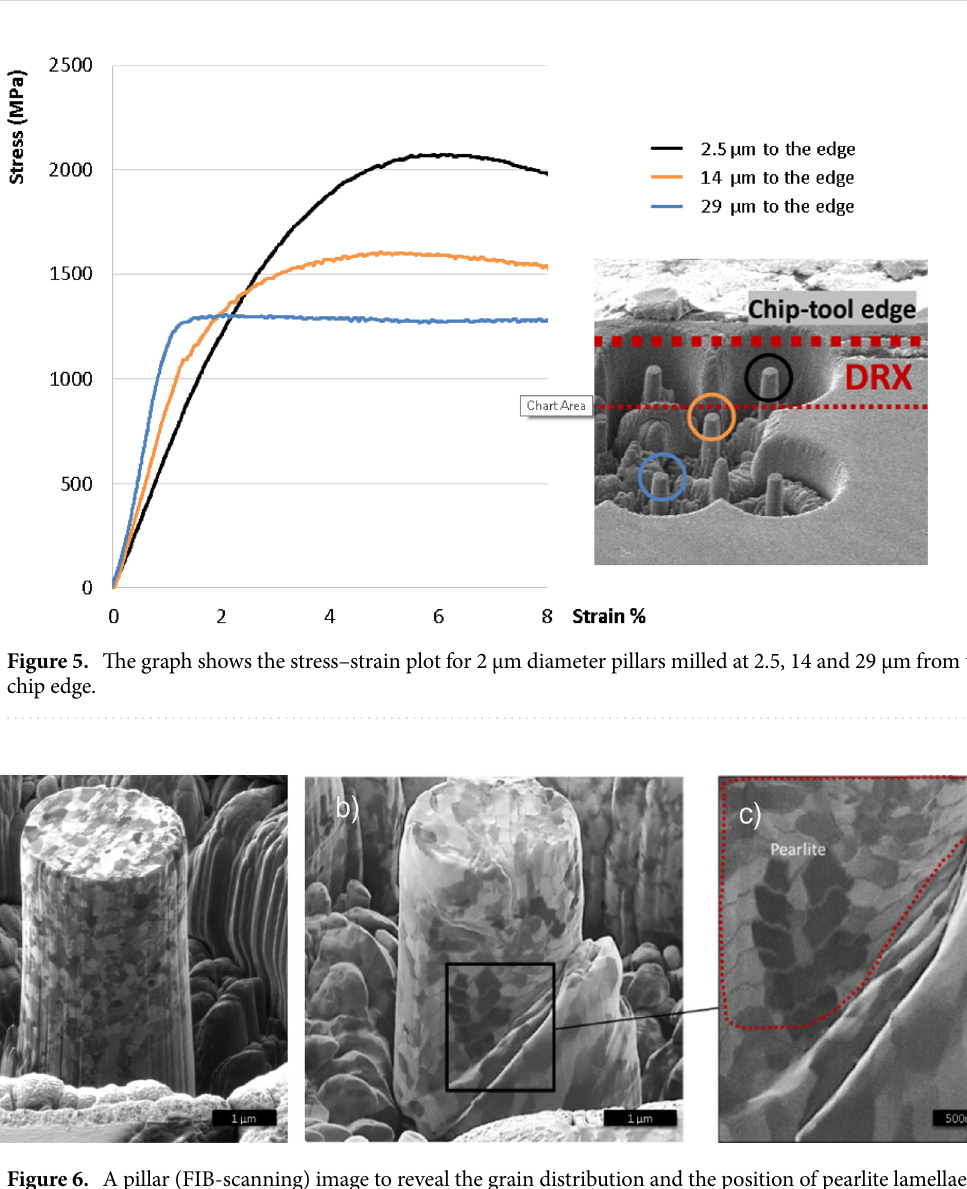
Figure 6. A pillar (FIB-scanning) image to reveal the grain distribution and the position of pearlite lamellae, locating the area of shear in the interface between ferrite and pearlite. Nanograined steel ( a ) depicts a homogeneous deformation, while in for larger grains the boundary of pearlite colonies ( b ) concentrates the shearing ( c